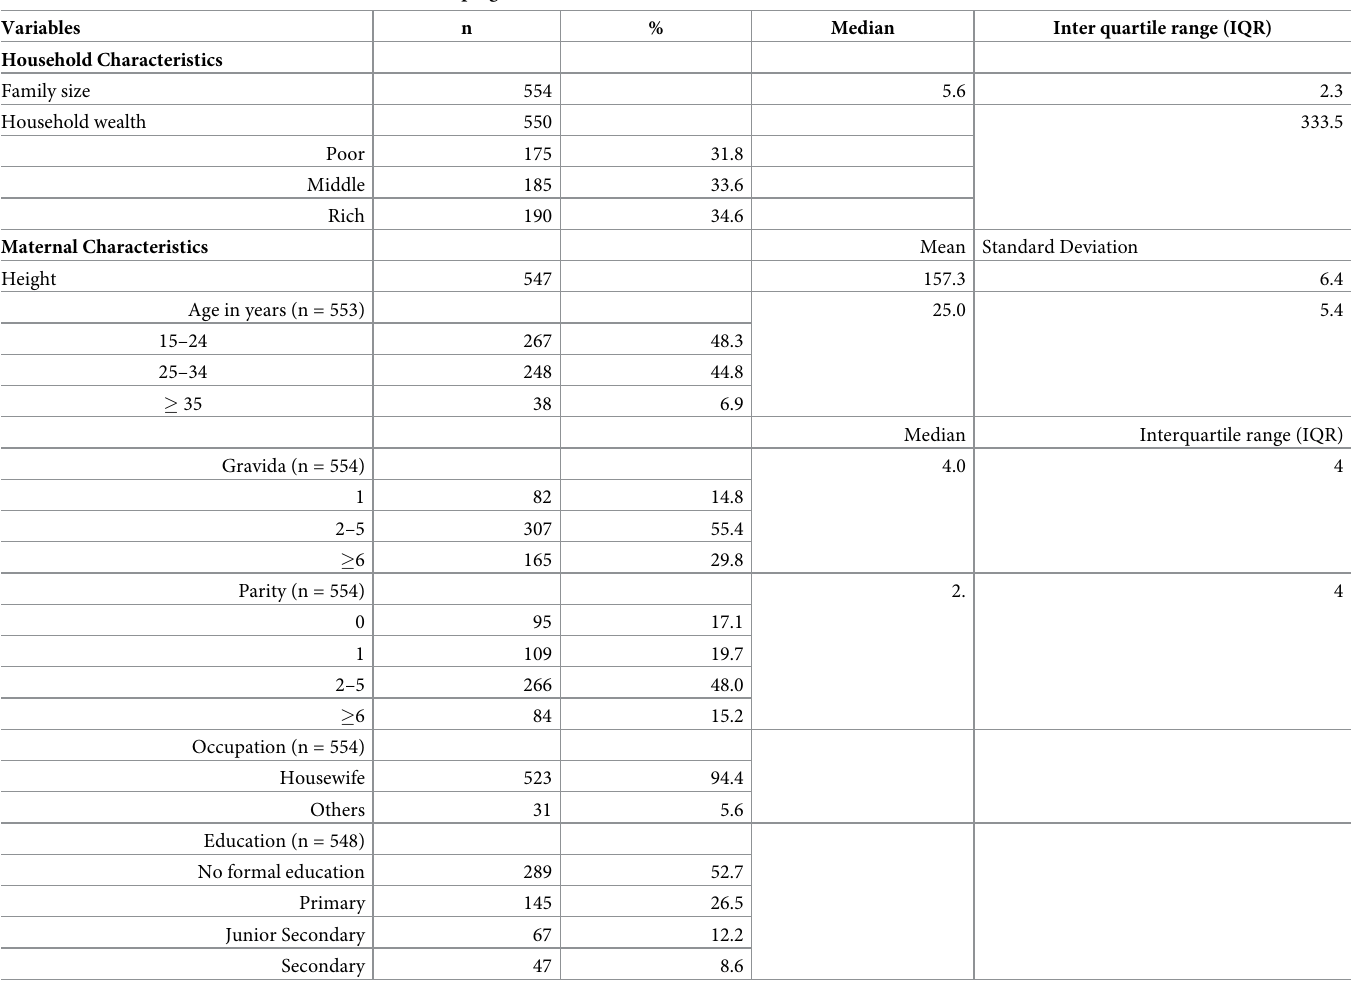
Table 1. Household and maternal characteristics of the pregnant mothers at first measurement Adami Tullu district, 2018.